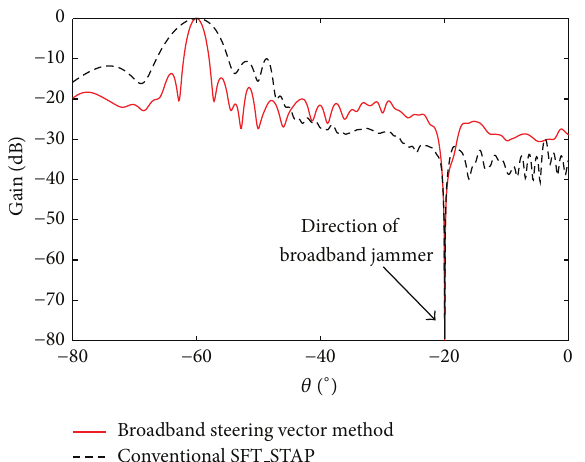
Figure 5: Adaptive pattern by broadband steering vector-based subarrayed fast-time STAP.